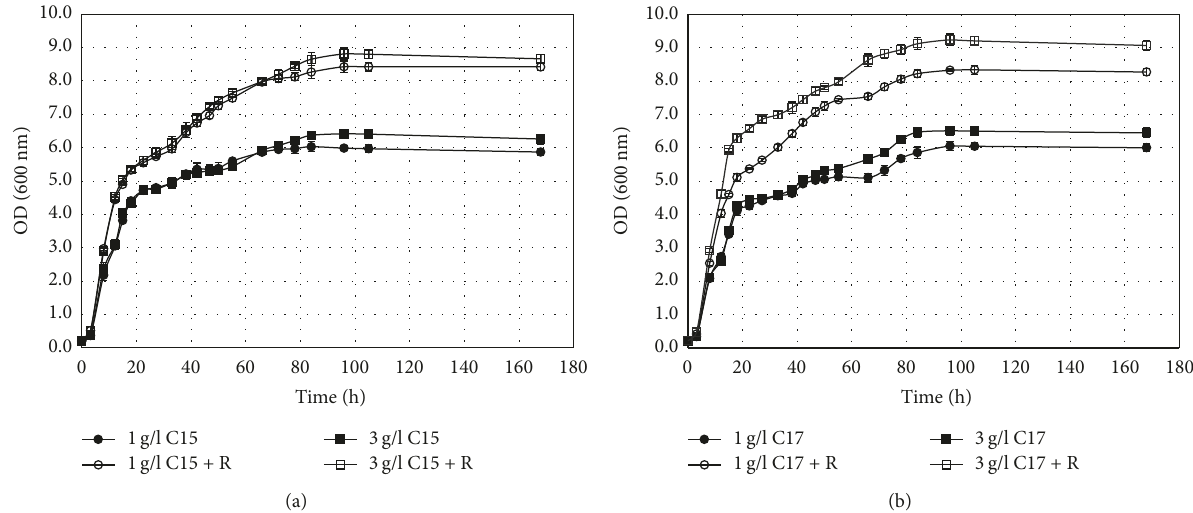
Figure 1: Growth curves Y. lipolytica CCY 30-26-36 on glucose with pentadecane (a) and glucose with heptadecane (b) as a carbon source (R = addition of rhamnolipid).